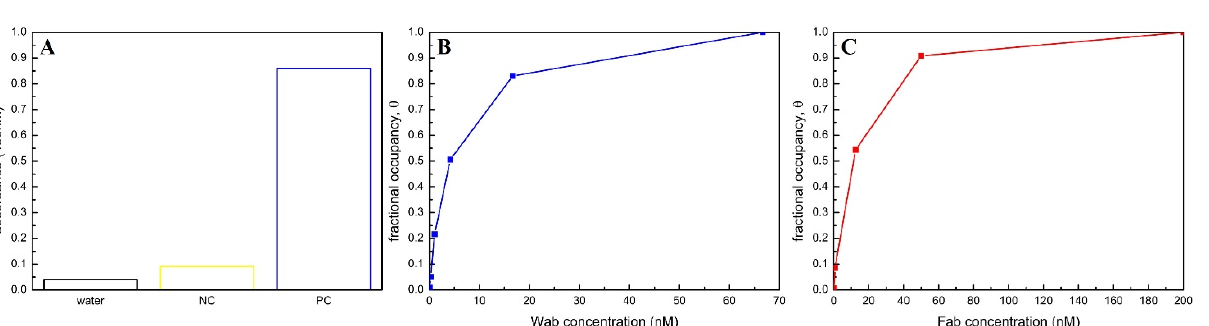
rabbit IgG (blue Y shapes) at concentrations of 100 pg/mL and 1 ng/mL, before binding with ( B ) 3 μ g/mL R18 aptamer (green curves) for signal enhancement. The Wab/PEG-SiNWFETs (sample 3) could only determine ( A ) rabbit IgG (blue Y shapes) at concentrations of 10 pg/mL, 100 pg/mL and 1 ng/mL, whereas the Fab/PEG-SiNWFETs (sample 4) could recog- nize ( A ) rabbit IgG (blue Y shapes) at concentrations of 1 pg/mL, 10 pg/mL, 100 pg/mL, and 1 ng/mL. Both of them were then also incubated in ( B ) 3 μ g/mL R18 aptamer (green curves) for signal enhancement. All the biosensing experiments in this Figure were performed in 150 mM BTP.